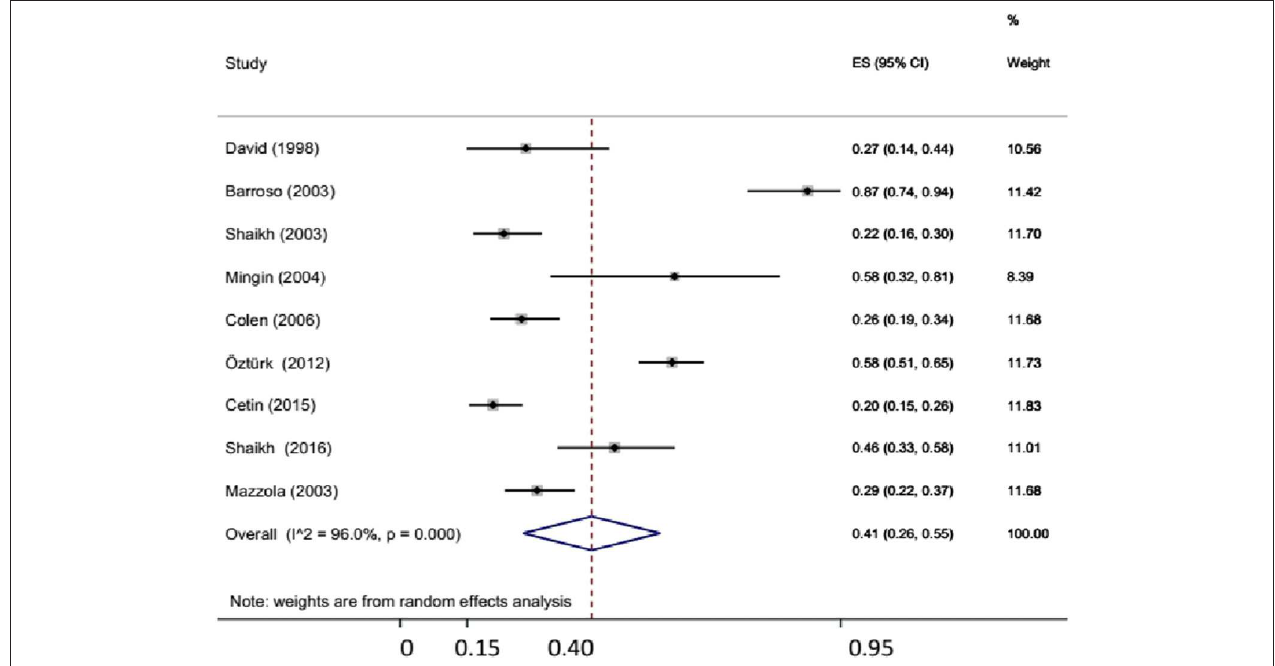
FIGURE 2 | Prevalence of bladder dysfunction in children with urinary tract infection (UTI) without primary vesicoureteral reflux